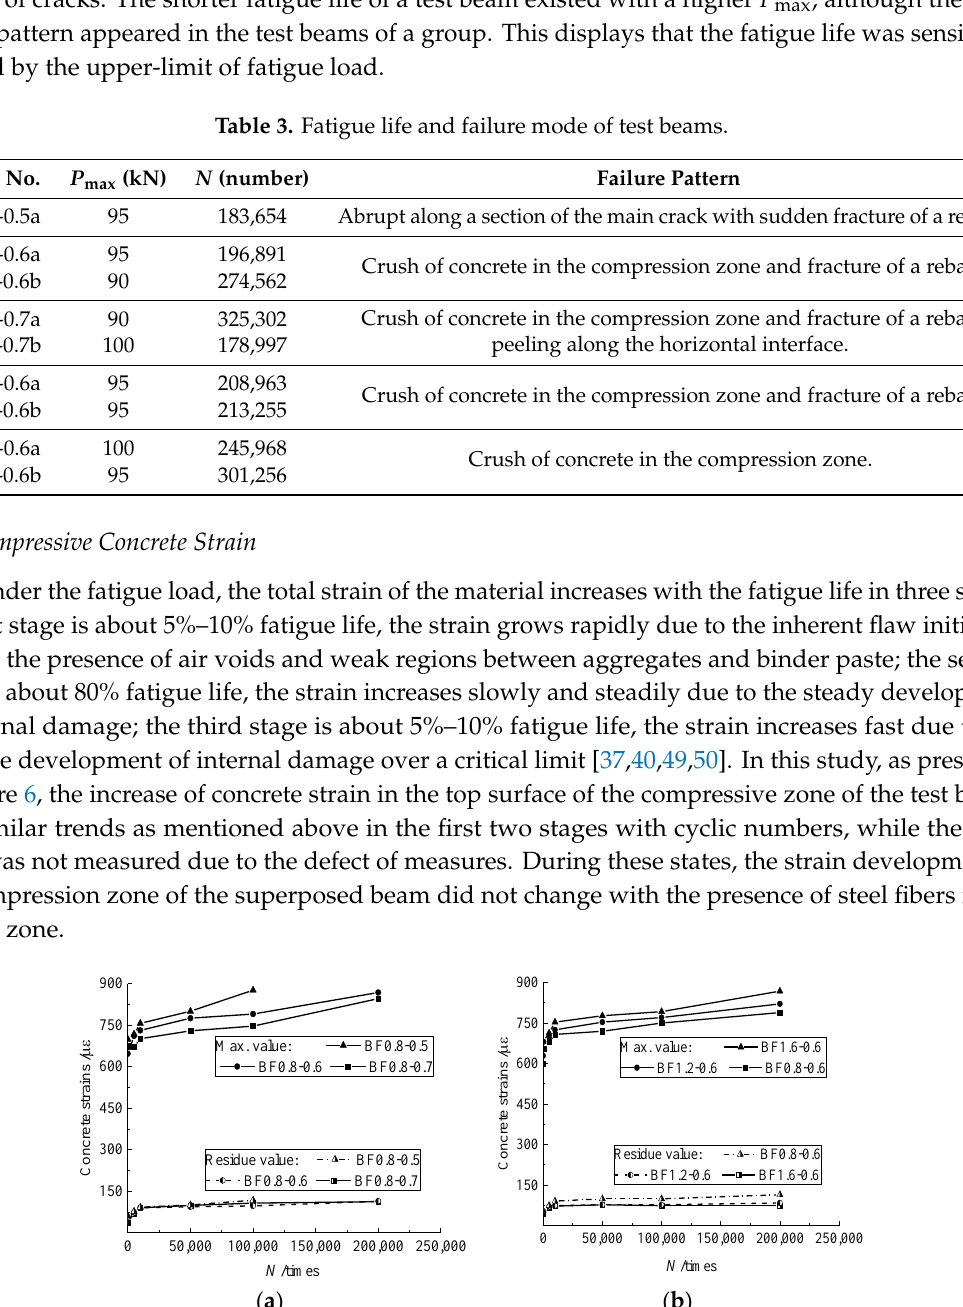
( b ) Figure 7. Changes of mid-span deflection affected by: ( a ) α h ; and ( b ) v f .